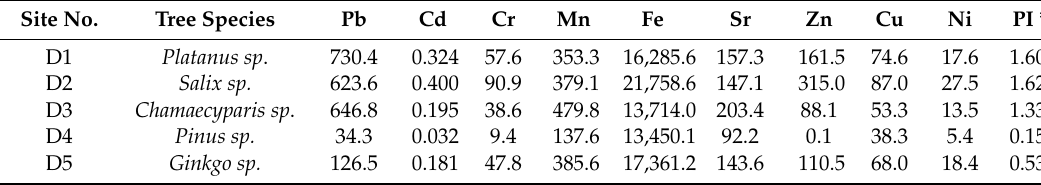
Table 3. Metal concentrations in surface soil samples and pollution index (PI) values. (Unit: mg/kg). Site